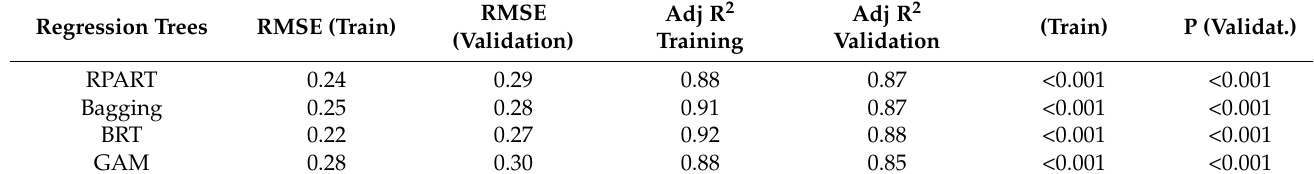
Table 5. Predictive performance of the different regression models. RMSE: root mean squared error. P: p value of statistical confidence.